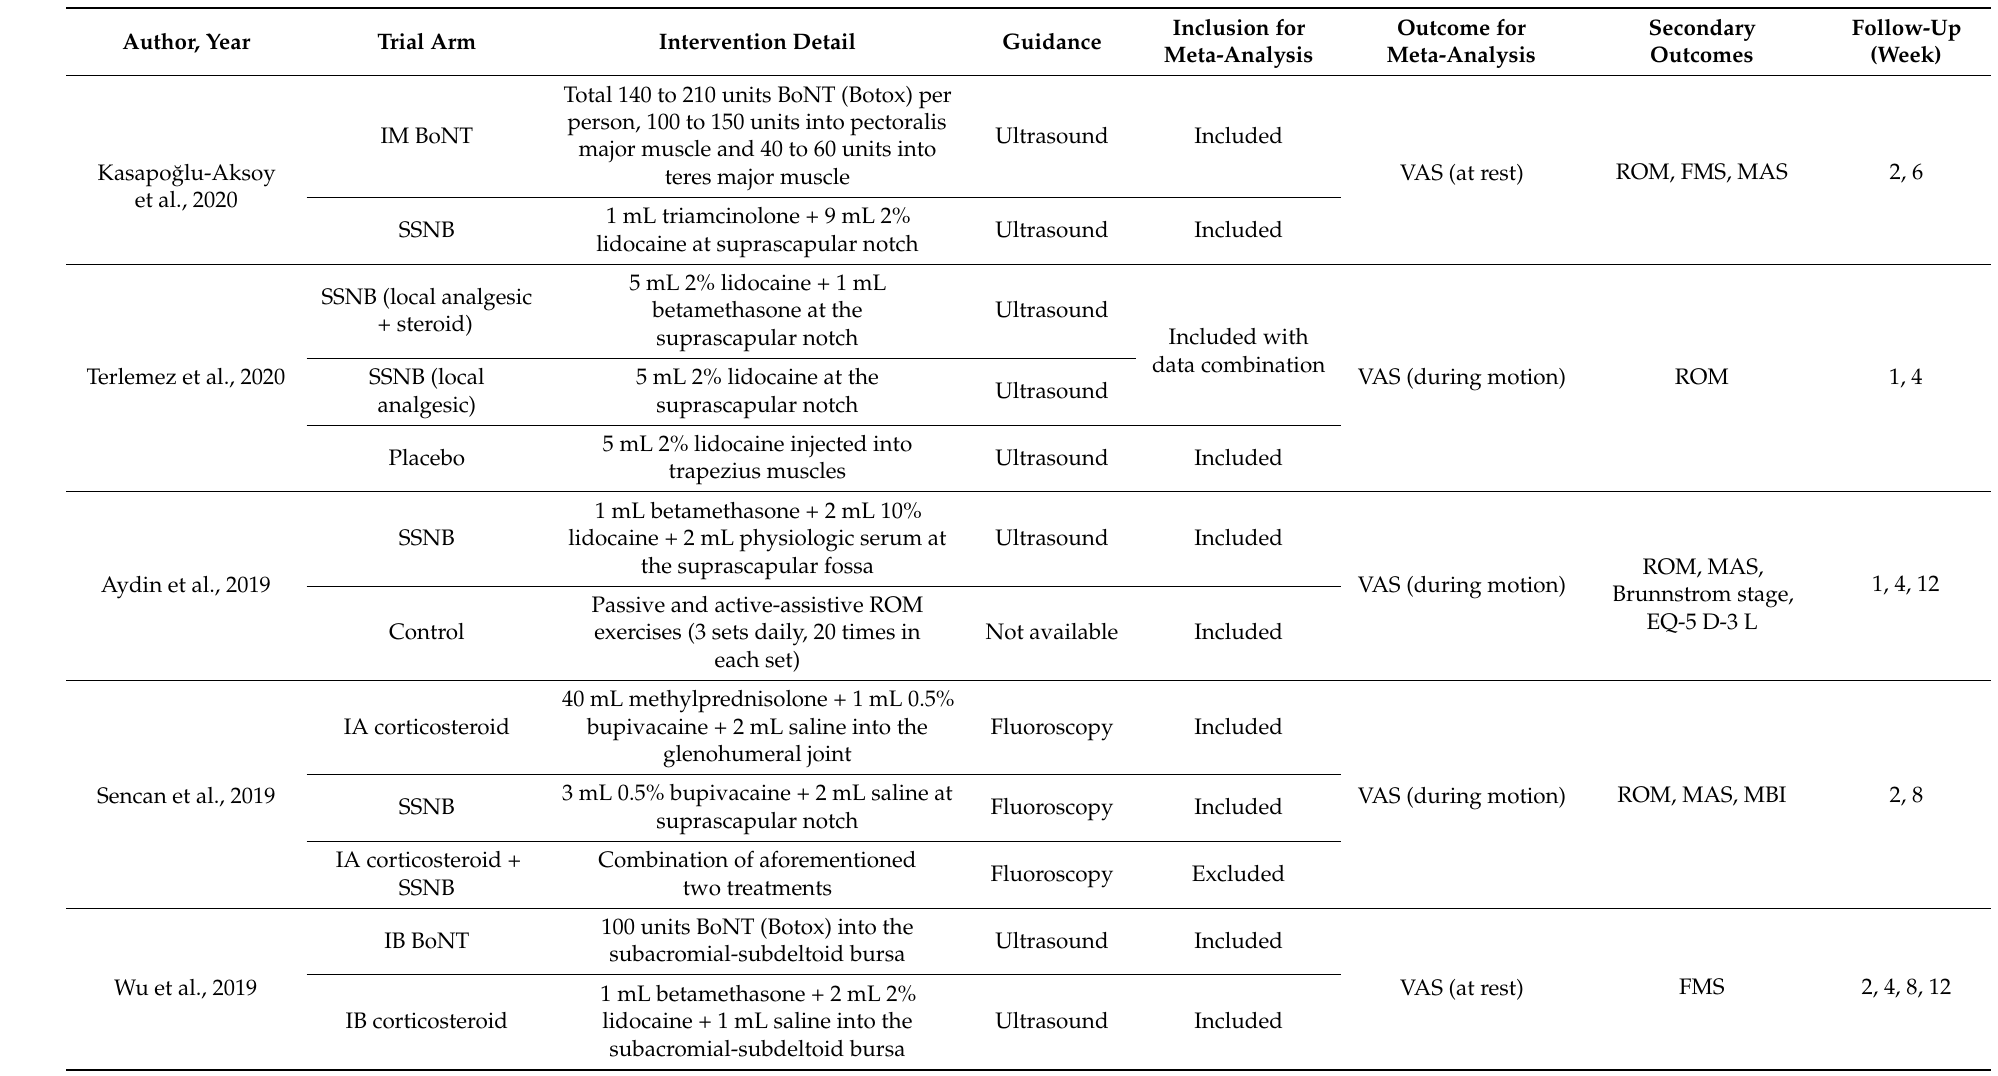
Table 2. Summary of intervention details in the retrieved